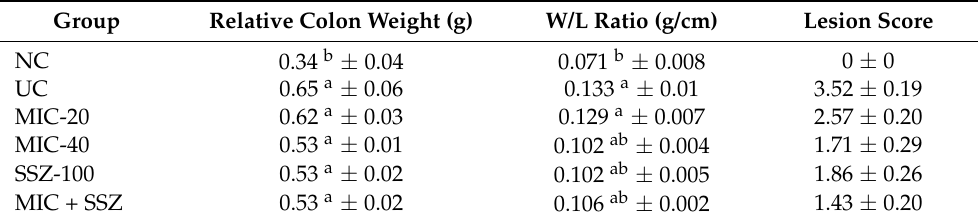
Table 3. Effect of miconazole, sulfasalazine and their combination on relative colon weight, W/L ratio and lesion score in AA-induced